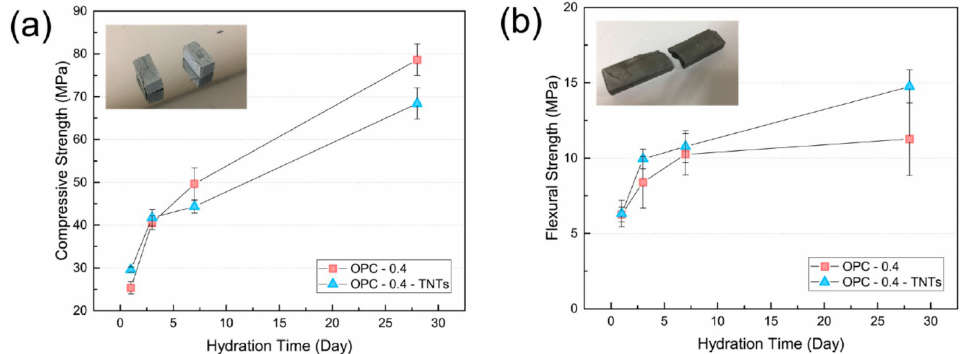
Figure 11. ( a ) Compressive and ( b ) flexural strength of ordinary Portland cement paste with TNTs (w / c =